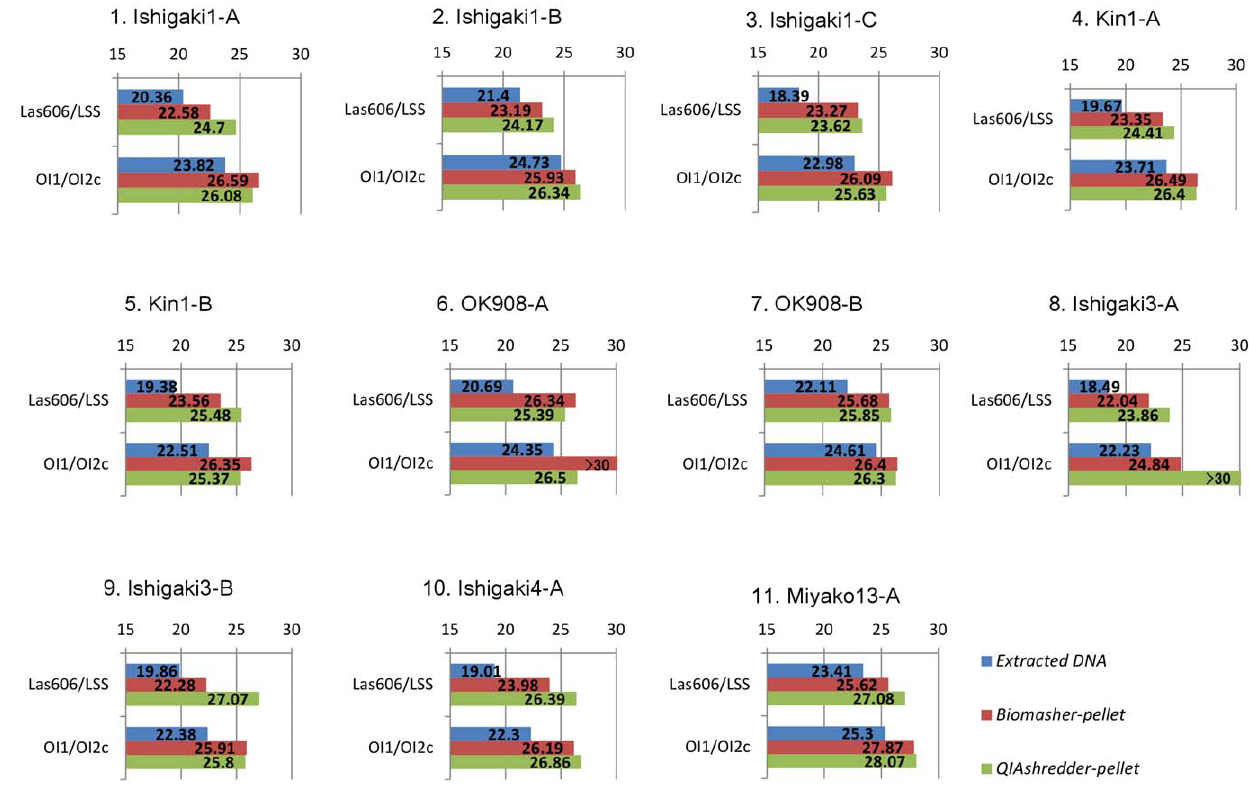
Figure 2. View of threshold (Ct) values derived from real-time PCR. Ct values were compared among PCR amplifications using three preparation methods and two primer sets. In each of 11 Las-infected citrus leaf samples, real-time PCR using Las606/LSS and OI1/OI2c primer sets with templates obtained from Extracted DNA , Biomasher-pellet , and QIAshredder-pellet was performed to derive each Ct value. The numbers in each graph are Ct values.